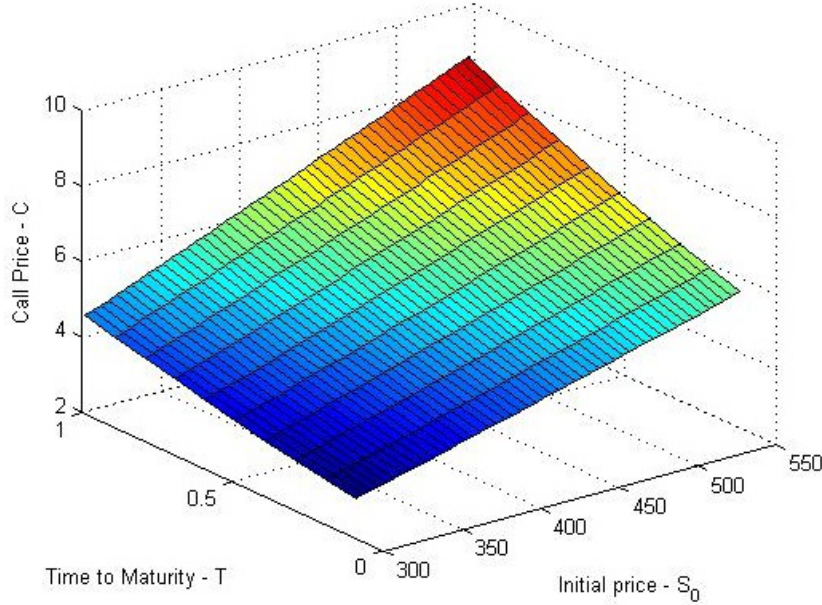
Figure 6. Up-And-Out call with Meixner( α = 0 . 3977 , β = − 1 . 494 , δ = 0 . 3462 ) with Stock Price S 0 = 450, Strike price K = 150, Barrier B = 350, σ = 0.1812, r = 0.167 and Time to maturity T =